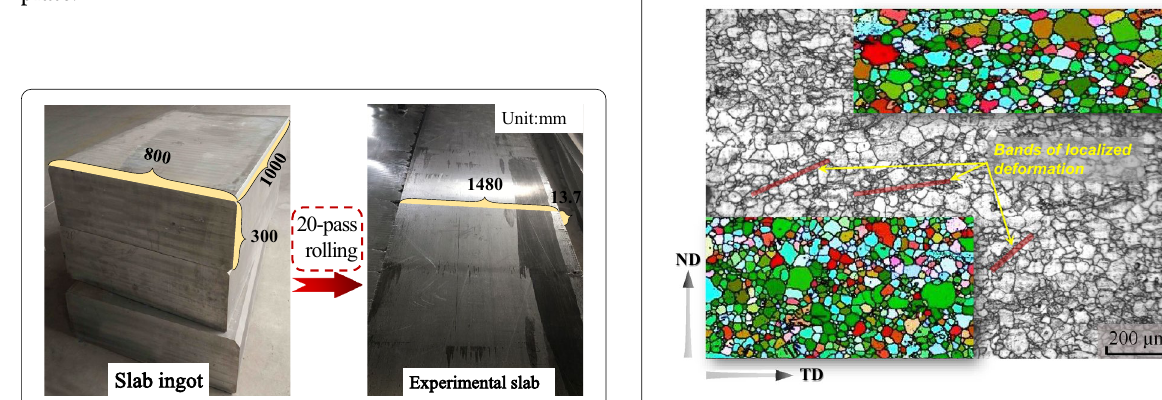
Figure 1 Parameters of the hot rolling mill and the source of the plates used in the experiment